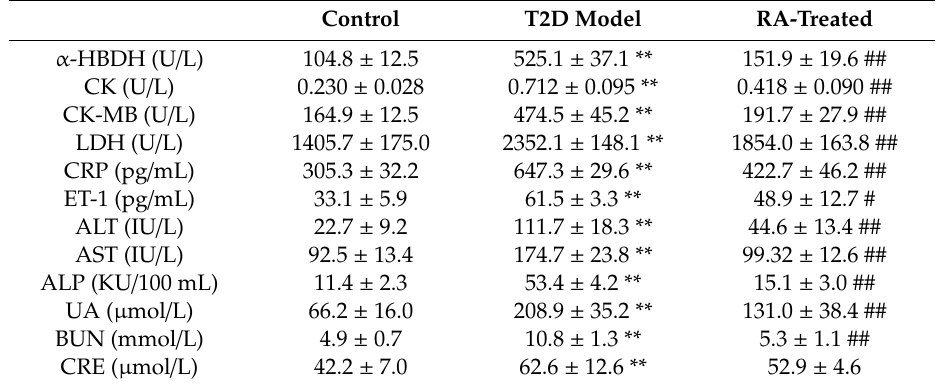
Table 1. Serum myocardial enzymes ( α -HBDH, CK, CK-MB and LDH), CRP and ET-1 levels of the control group, T2D model group and RA-treated group (40 mg / kg / day) at the end of the experiment.